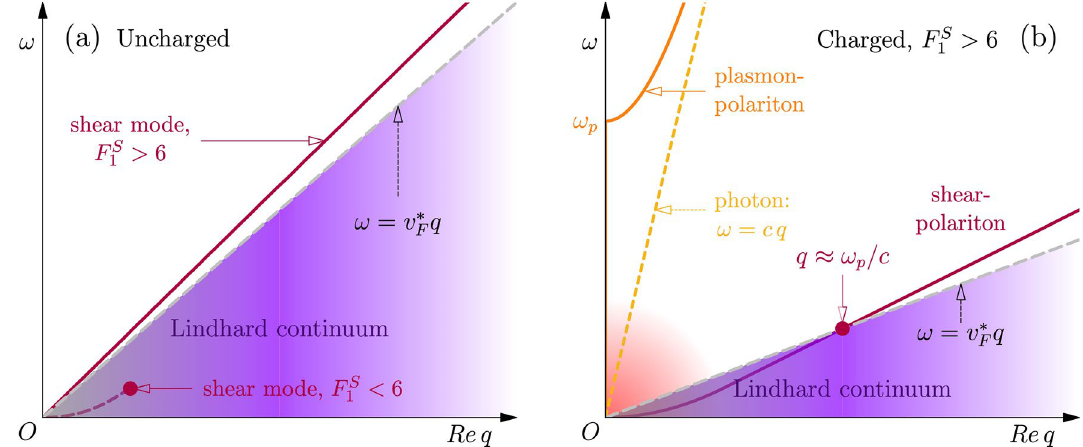
Figure 1. Transverse collective mode spectrum of neutral and charged Fermi liquids. ( a ) Sketch of the real part of the dispersion relation of transverse sound in a neutral Fermi liquid, corresponding to a pole in the transverse susceptibility. For F S 1 > 6 (solid line) transverse sound propagates at frequencies above the Lindhard continuum (purple-shaded area); for F S 1 < 6 transverse sound is Landau-damped (dashed line), and the pole disappears deep inside the continuum at an F S 1 -dependent frequency marked by the red dot. ( b ) Sketch of the real part of the dispersion relation of shear collective modes (polaritons) in a charged Fermi liquid, in the long-wavelength propagating-shear regime with F S 1 > 6 , obtained from the Fermi-liquid transverse dielectric functin in linear response. The interaction of the photon root (dashed golden line) with the transverse sound of the neutral case (panel a ) generates the usual plasmon–polariton (solid orange line), which propagates above the plasma frequency ω p , and the shear-polariton (red solid line), which bears the signatures of Fermi-surface shear rigidity in the charged case. The shear-polariton is repelled by the interaction with the nearby photon root at low frequency (red-shaded area), so that it bends with quadratic dispersion and submerges into the continuum at ω p / c q ∝